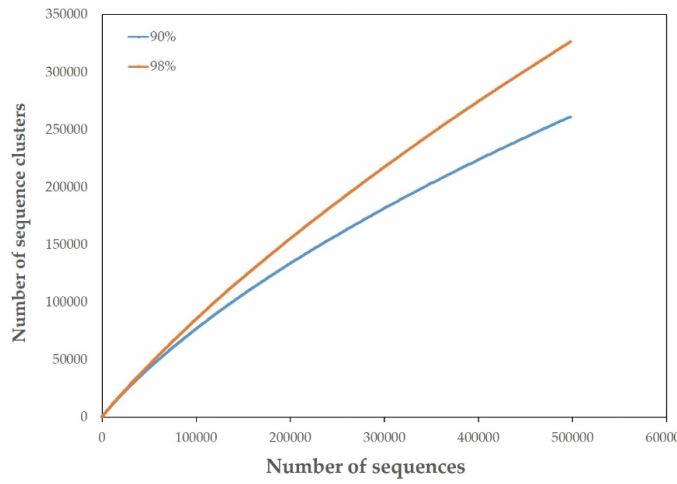
Figure 2. Rarefaction curve of the JRE virome generated by Metavir. Clustering were set at 90% and 98%